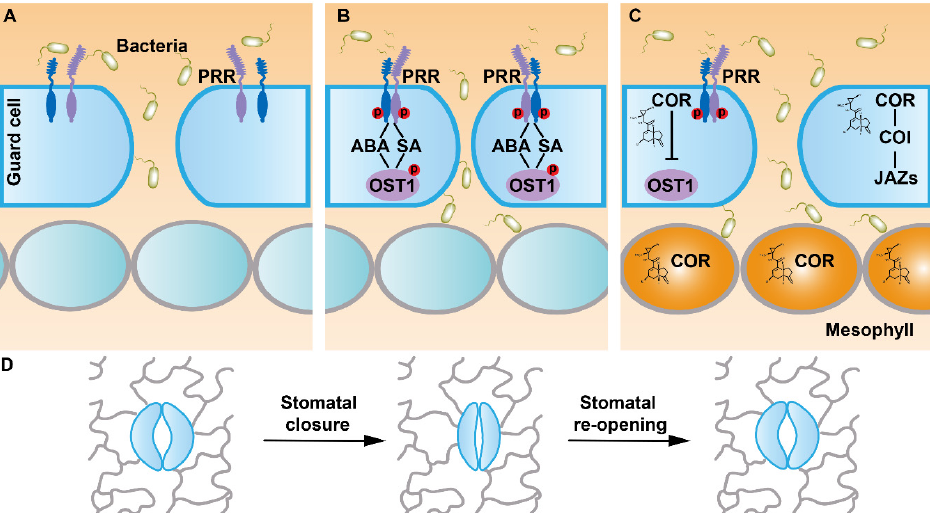
Figure 1. A general model of stomatal movement in plant defense against bacteria. The stomata are formed by two guard cells and the pore between them. The stomata are the main entry point of pathogen invasion. ( A ) When bacteria such as Pseudomonas syringae pv. tomato DC3000 ( Pst DC3000) invade plants, pathogen-associated molecule patterns (PAMPs) can be sensed by membrane-localized pattern recognition receptors (PRRs) such as FLAGELLIN-SENSING 2 (FLS2). ( B ) FLS2 recruits its co- receptor BRI1-ASSOCIATED RECEPTOR KINASE 1 (BAK1) after perception of the PAMP to trigger rapid stomatal closure and limit bacterial invasion through ABA/SA signaling and a downstream kinase OPEN STOMATA 1 (OST1). ( C ) Pst DC3000 releases phytotoxin coronatine (COR) which is a structural mimic of JA conjugated to isoleucine (JA-Ile) to re-open stomata through the JA signaling pathway for more bacteria to infect plants. ( D ) A schematic diagram of stomatal movement during bacteria